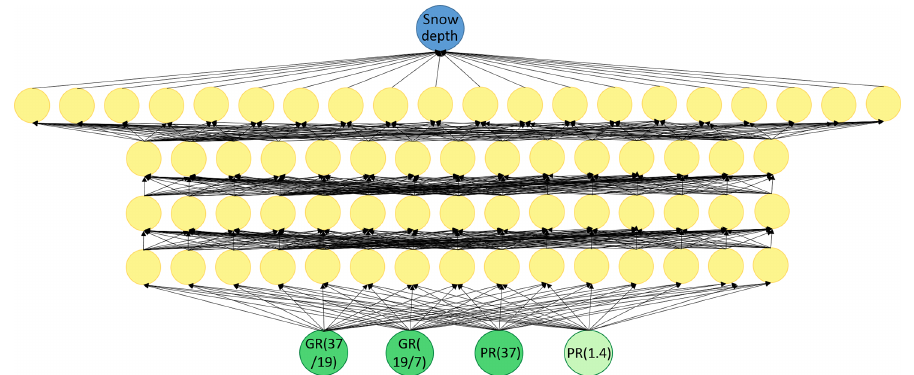
Figure 2. Architecture of the AMSR2 + SMOS neural network: the 37 / 19 gradient ratio, the 19 / 7 gradient ratio and the polarization ratio at 37GHz are used as input from AMSR2 (green circles) and the polarization ratio at 1.4GHz is used as input from SMOS (light green circle). They are transformed by four fully connected hidden layers with 15 or 20 neurons each (yellow circles) to finally produce snow depth as output (blue